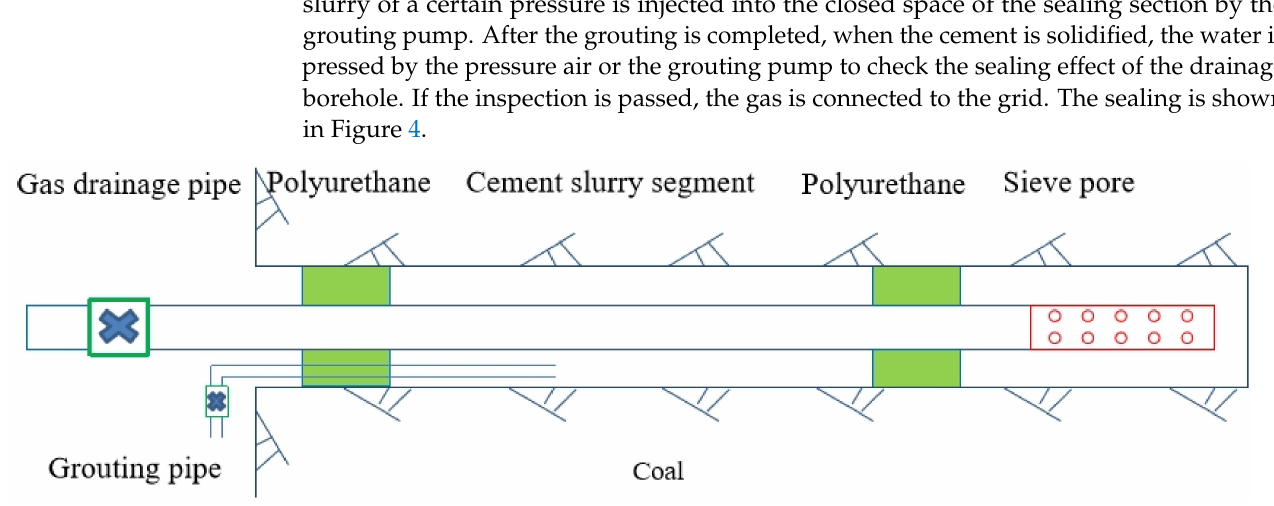
Figure 4. Schematic diagram of polyurethane and slurry sealing.